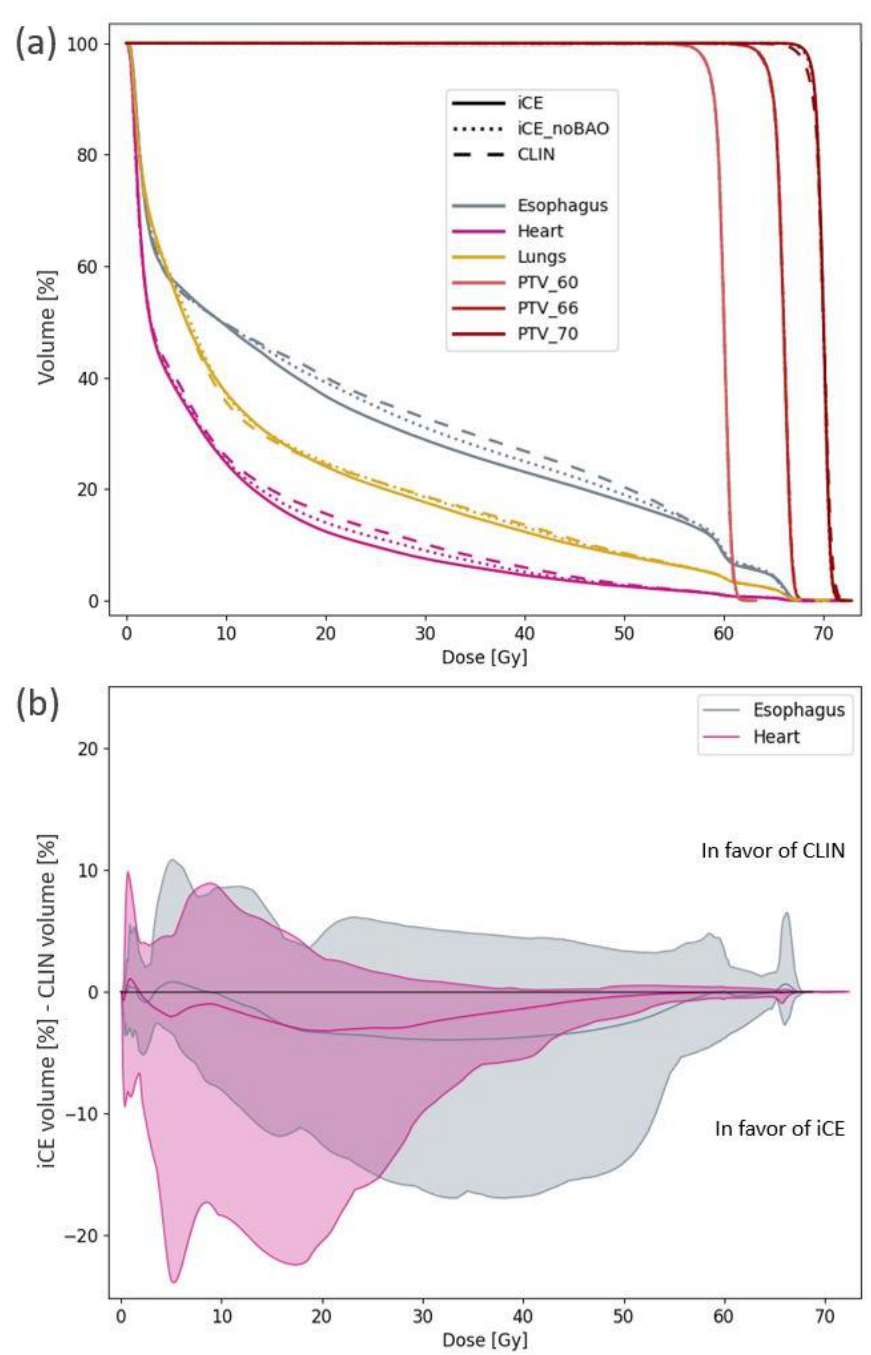
Figure 1. ( a ) Population average DVHs for PTV and OARs for CLIN, iCE and iCE_noBAO plans. 10 patients had PTV_60, 15 had PTV_66 and 1 had PTV_70. ( b ) Average DVH differences between CLIN and iCE plans for heart and esophagus (central bold lines) with 95% confidence intervals (shaded areas). For lungs, the differences were small and clinically in- significant.